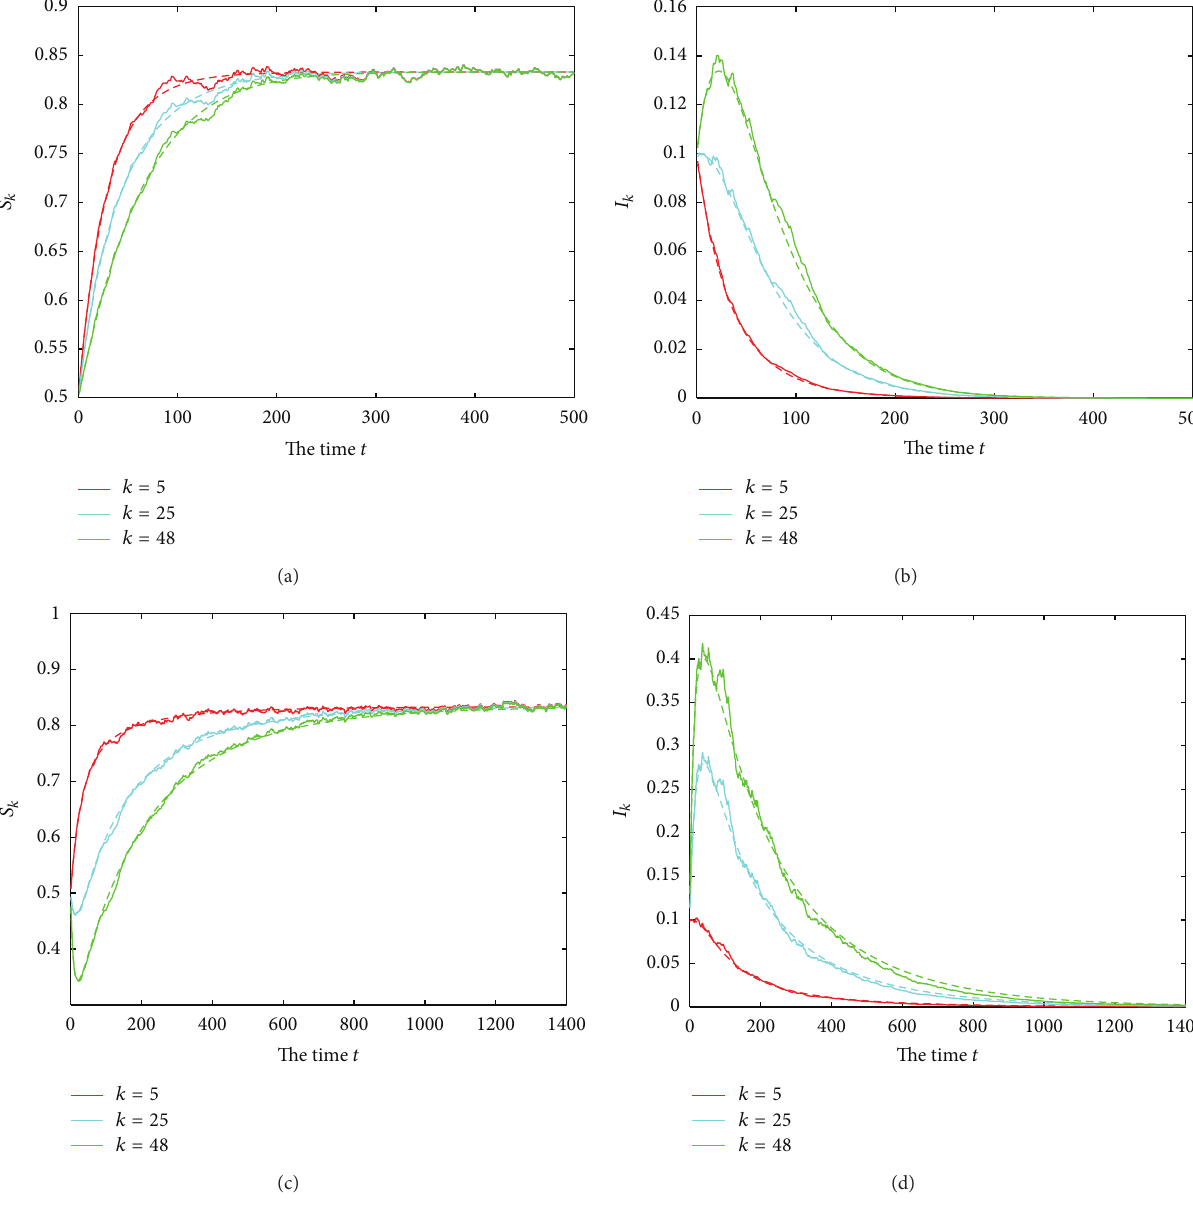
Figure 1: 𝜆 = 0.025 , 𝜎 𝑘1 = 0.005 , 𝜎 𝑘2 = 0.03 , 𝑅 0 ≤ 1 . (a), (b) 𝑃(𝑘) = 𝑚 𝑘 exp (−𝑚)/𝑘! , 𝑚 = 6 , 𝑅 0 = 0.4704 ≤ 1 ; (c), (d) 𝑃(𝑘) = 2𝑚 2 𝑘 −3 , 𝑚 = 3 , = 0.9071 ≤ 1 𝑅 0